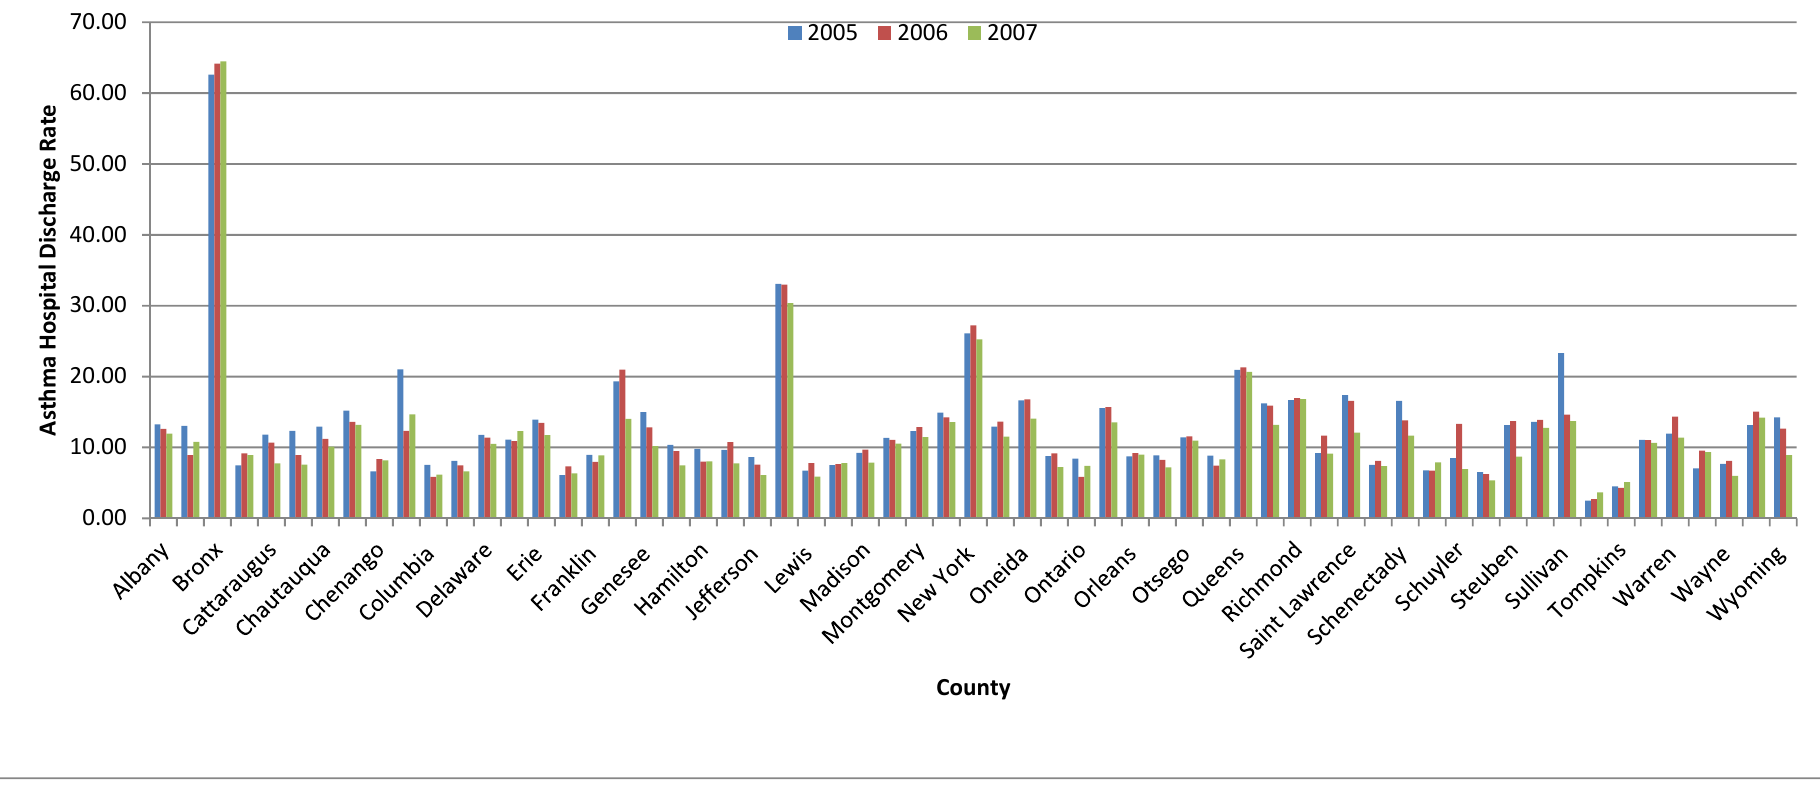
Figure 2. ( a ) County-wise asthma discharge rate in counties of New York State during 2005 to 2007; ( b ) County-wise asthma emergency department visit rate in counties of New York State during 2005 to